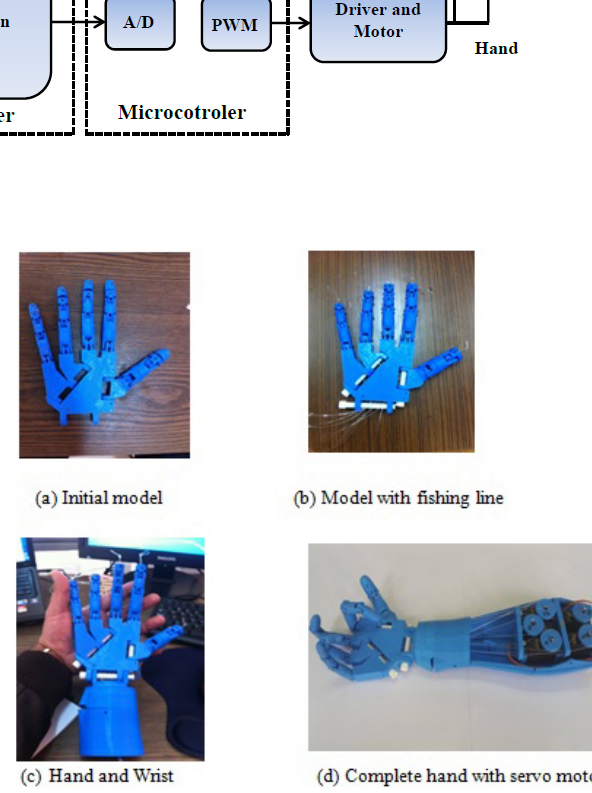
Figure 4. Images of the designed hand with motor and